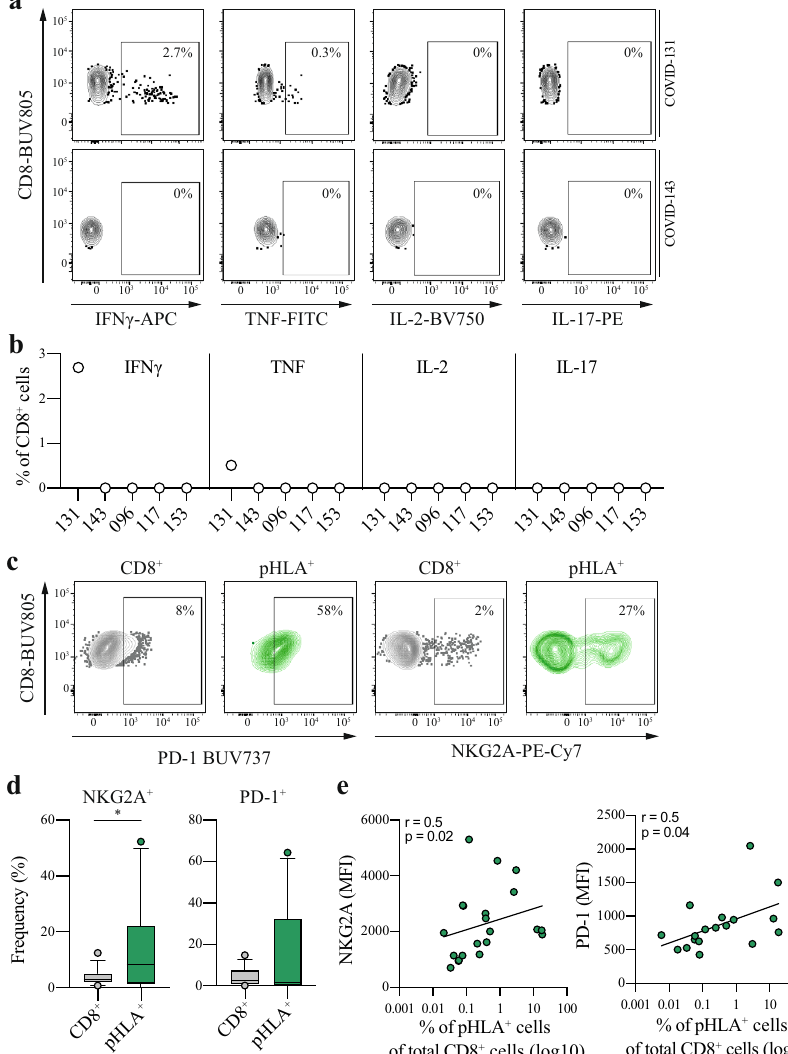
Fig. 3 Characterization and functional assessment of SARS-CoV-2-speci fi c CD8 T cells. a Representative gating used to assess the functional capacity of TTD-speci fi c CD8 T cells of 2 COVID-19 patients. Functionality was assessed based on production of IFN γ , TNF, IL-2, and IL-17 after 12 h peptide stimulation with TTD. Percentages represent the frequency of cytokine-producing cells. Full gating strategy is shown in Supplementary Fig. 3a – c. b Expression of IFN γ , TNF, IL-2, and IL-17 in CD8 T cells of COVID-19 patients ( n = 5) with acute disease after 12 h peptide stimulation with TTD. DMSO control-subtracted percentages are shown. Two independent experiments were performed for patient COVID-143 and COVID-153 with similar results. c Representative fl ow cytometric plots illustrating the gating strategy used to quantify the fraction and expression levels of PD-1 and NKG2A on total CD8 T cells (CD8 + , gray) and SARS-CoV-2-speci fi c CD8 T cells (pHLA + , green) in COVID-112. The gates applied for detected SARS-CoV-2-speci fi c CD8 T cell responses were based on total CD8 T cells. d Differences in the fraction of NKG2A + or PD-1 + cells of SARS-CoV-2-speci fi c CD8 T cells (pHLA + , n = 27) compared to bulk CD8 T cells (CD8 + , n = 32) of COVID-19 patients with acute disease. Box plots indicate the median (line), 25th and 75th percentile (box), 5th and 95th percentile (whiskers), and outliers (single circles). Statistical signi fi cance was tested with a two-tailed Mann – Whitney U test, NKG2A: P = 0.0427, PD-1: P = 0.7651. Source data are provided as a Source data fi le. e Correlation analysis between the expression levels (MFI) of NKG2A + (pHLA + , n = 21) or PD-1 + (pHLA + , n = 18) on SARS-CoV-2-speci fi c CD8 T cells and the magnitude of SARS-CoV-2-speci fi c CD8 T cell responses. Two- tailed Spearman correlation analysis was performed, NKG2A: P = 0.0199, r = 0.5, PD-1: P = 0.0361, r = 0.5. TTD TTDPSFLGRY, pHLA peptide human leukocyte antigen. * P < 0.05. Source data are provided as a Source data fi